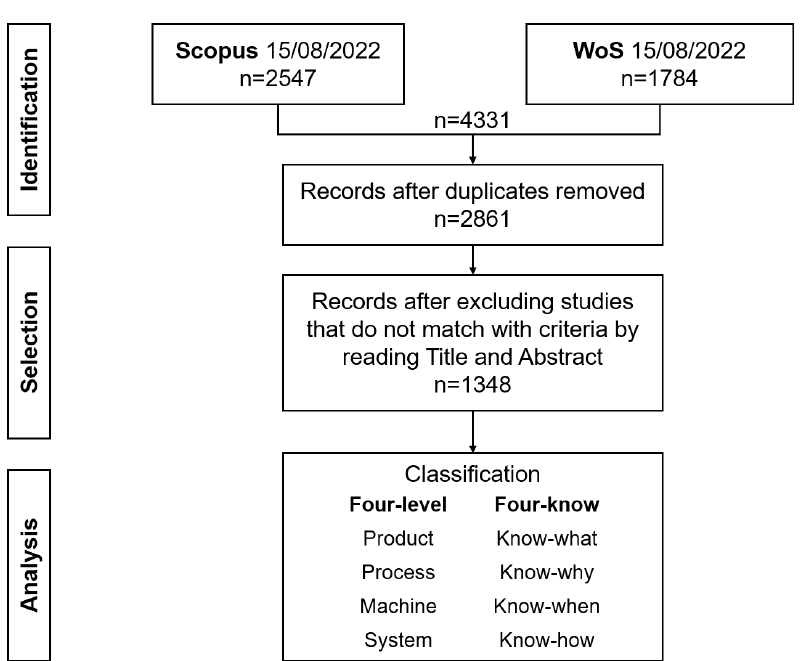
Figure 2. The overall literature review process following PRISMA. All identified documents were screened and assessed for eligibility, then subjected to Four-Level and Four-Know classification.